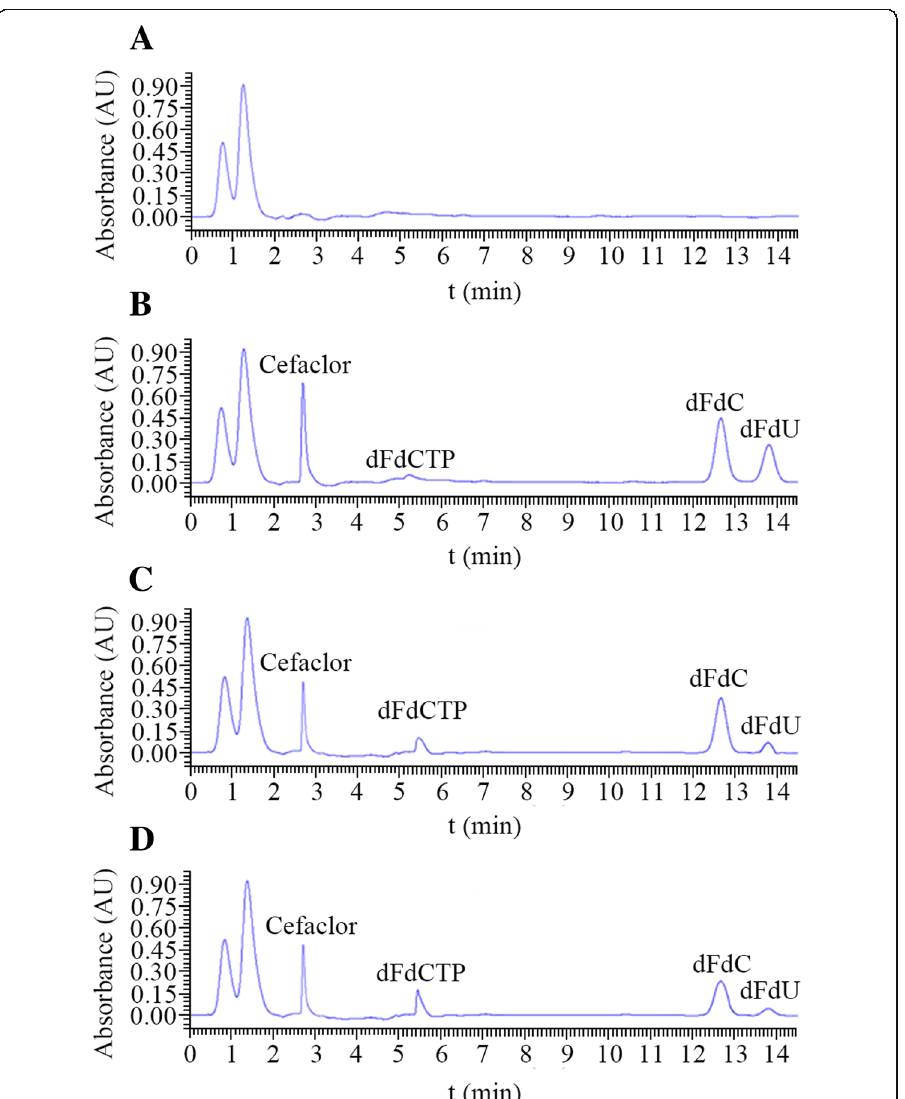
Fig. 4 Representative chromatograms (268 nm) of PANC-1 cell lysates after metabolism under differentconditions of no drugs ( a ) or loading dFdC at IC 50 along with a heat treatment of 37 °C ( b ), 41 °C ( c ) or 43 °C ( d